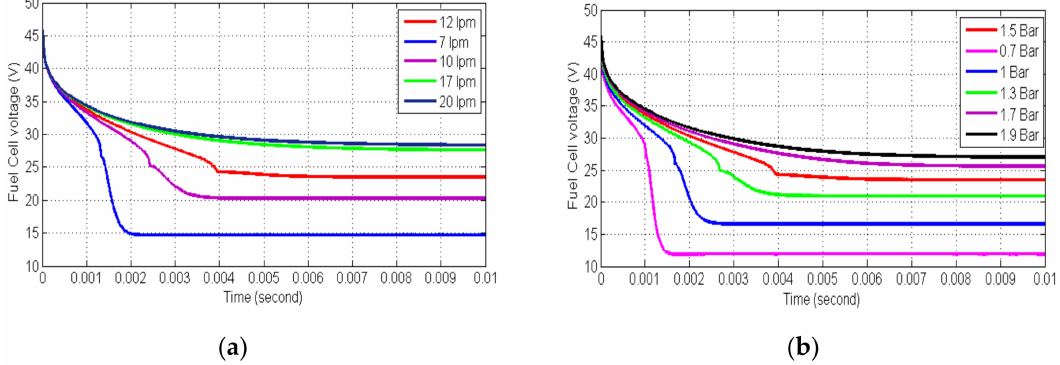
Figure 7. PEMFC voltage for: ( a ) different fuel flow rate; ( b ) different fuel supply